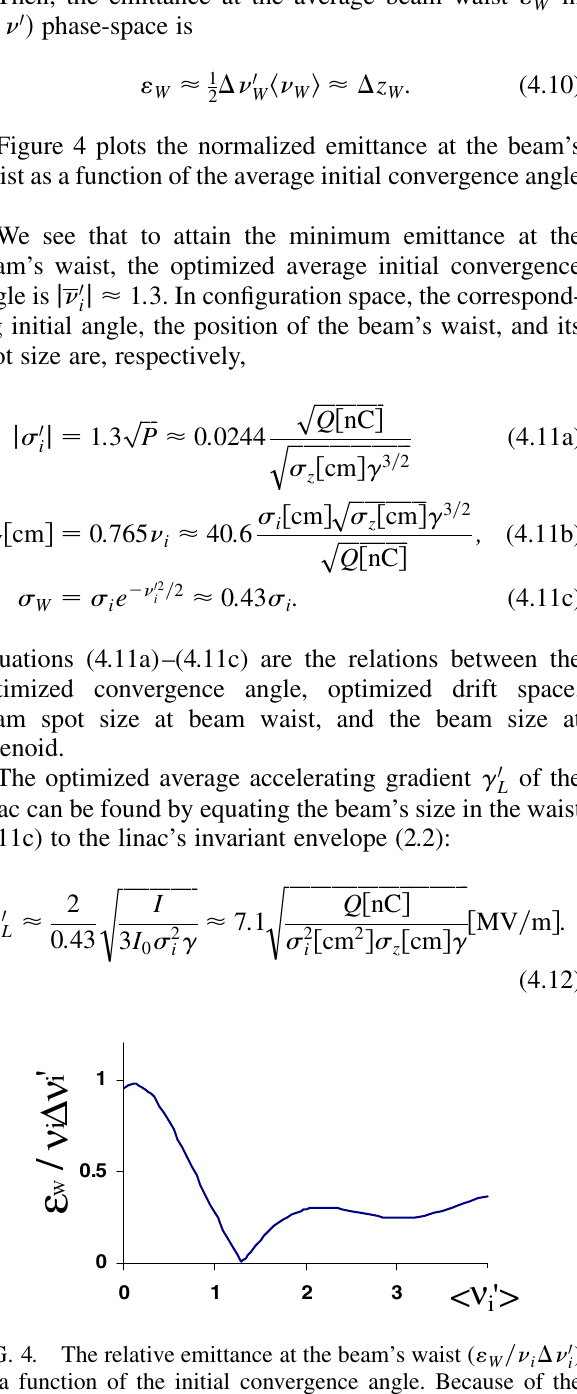
FIG. 3. Left: The phase-space immediately after the solenoid, in which the end points of the slices’ emittances are oriented perpendicular to the (cid:6) axis (line A). Right: The phase-space near the beam’s waist.